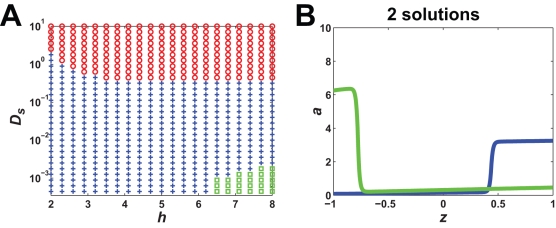
Bifurcation diagram of model behavior as a function of the parameters Ds (diffusion) and h (positive feedback).(A) This plot was constructed by exhaustive simulation of the FF model (k
1 = 10 s−1; Lmid = 1, Lslope = 0.01 µm−1) over a range of parameter pair values (Ds, h). Three behavior classes were observed. (1) One steady-state solution (blue, +). (2) Two solutions (green, square). (3) Limit-cycle oscillations (red, circle). (B) An example of the two solutions class in which there is a forward (blue) and a reversed (green) polarization solution to a right-to-left gradient.